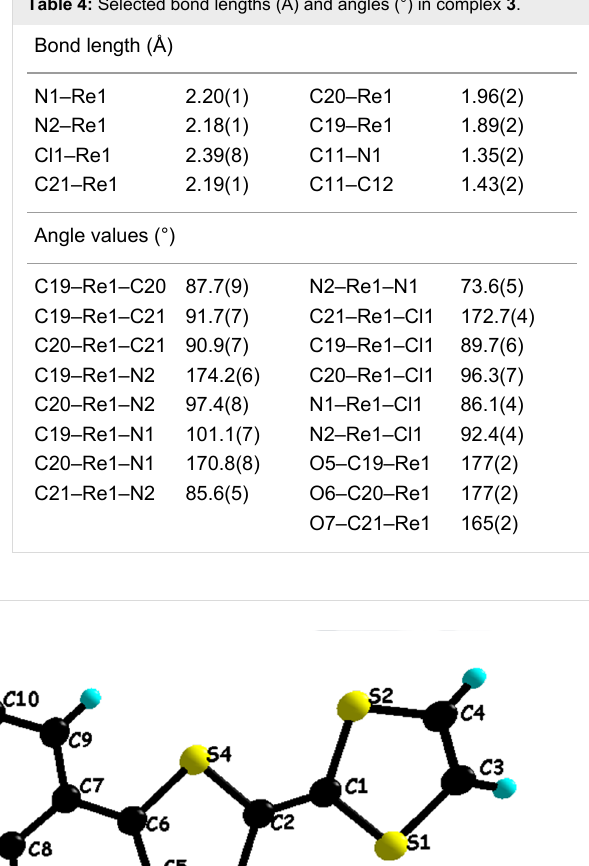
Table 4: Selected bond lengths (Å) and angles (°) in complex 3